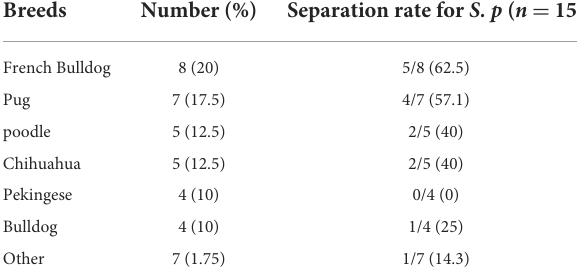
TABLE 3 Frequency of bacterial eye disease among breeds in 40 dogs.